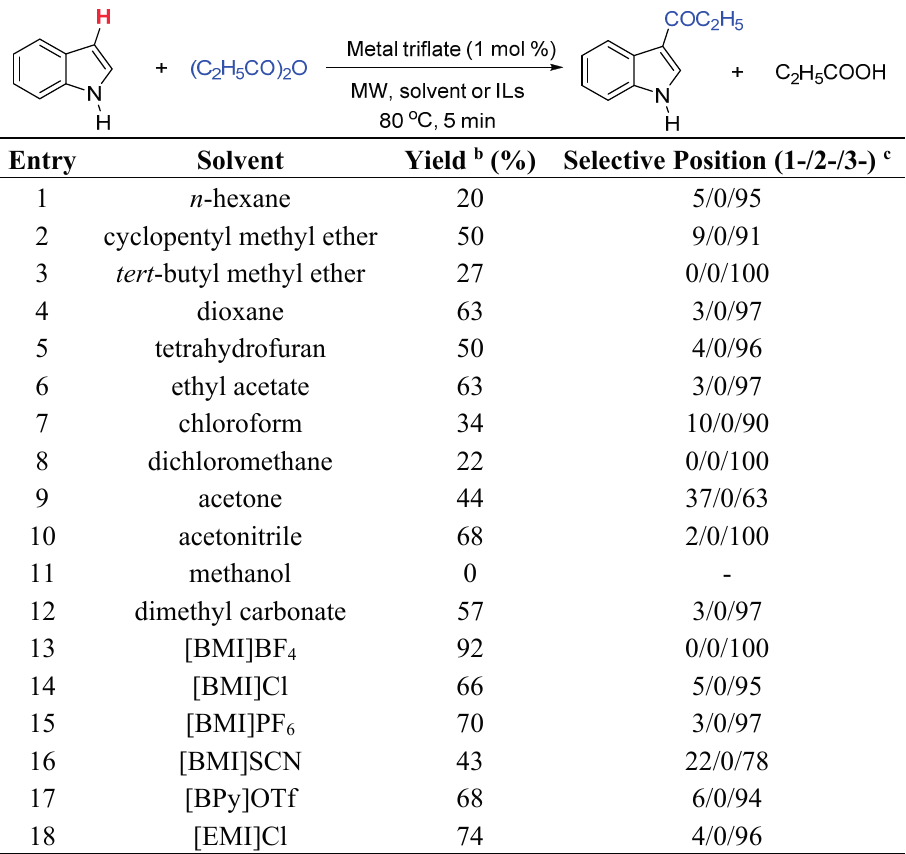
Table 2. Effect of solvents under microwave irradiation (80 °C, 5 min) a